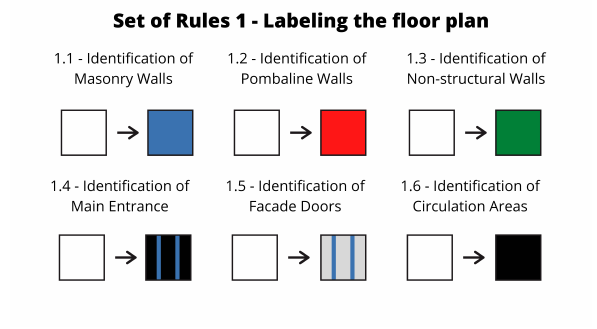
Figure 7. Grammar approach to label the original floor plan.